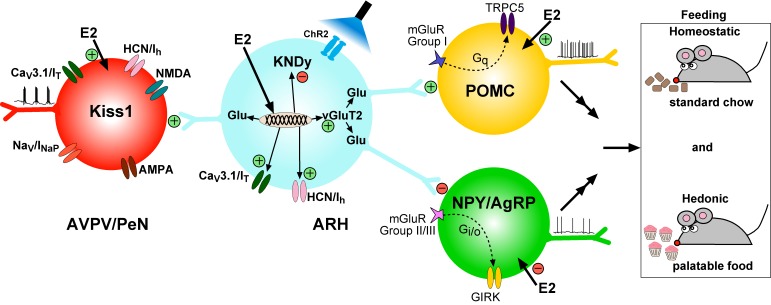
Working Model. KNDy (Kisspeptin, NKB, Dynorphin) neurons in the ARH express CaV3 (IT) and HCN (Ih) channels (currents) that are upregulated by E2 and contribute to increased excitability of Kiss1ARH neurons.Kiss1AVPV/PeN neurons also express CaV3 (IT), HCN (Ih) and Nav (INaP) channels that are highly up-regulated by E2 along with Kiss1 mRNA expression. Notably, E2 induces spontaneous, repetitive burst firing activity in Kiss1AVPV/PeN neurons necessary for the release of GnRH (Wang et al., 2016; Zhang et al., 2015). E2 also directly excites POMC neurons via inhibition of GIRK current, but inhibit NPY/AgRP neurons via activation of GIRK current (Kelly and Rønnekleiv, 2015). These congruent actions of E2 on POMC and NPY/AgRP neurons contribute to the control of homeostatic feeding. High frequency photo-stimulation (focal light stimulation of channel rhodopsin, ChR2) in Kiss1ARH neurons releases glutamate to further excite POMC neurons via mGluRs group I and inhibit NPY/AgRP neurons via mGluRs group II/III; and excite Kiss1AVPV/PeN neurons via NMDA/AMPA receptors. Ablating Slc17a6 from Kiss1ARH neurons, results in the abrogation of glutamate release onto POA and ARH neurons. The lack of glutamate release from Kiss1ARH neurons appears to have little or no effect on estrous cyclicity, an indication that the direct effects of E2 to increase the excitability of Kiss1AVPV/PeN neurons is sufficient to drive the reproductive cycle. However, E2-treated Slc17a6 KO Kiss1 mice develop a condition place preference for sucrose indicative of positive motivational effect of sucrose in these females.